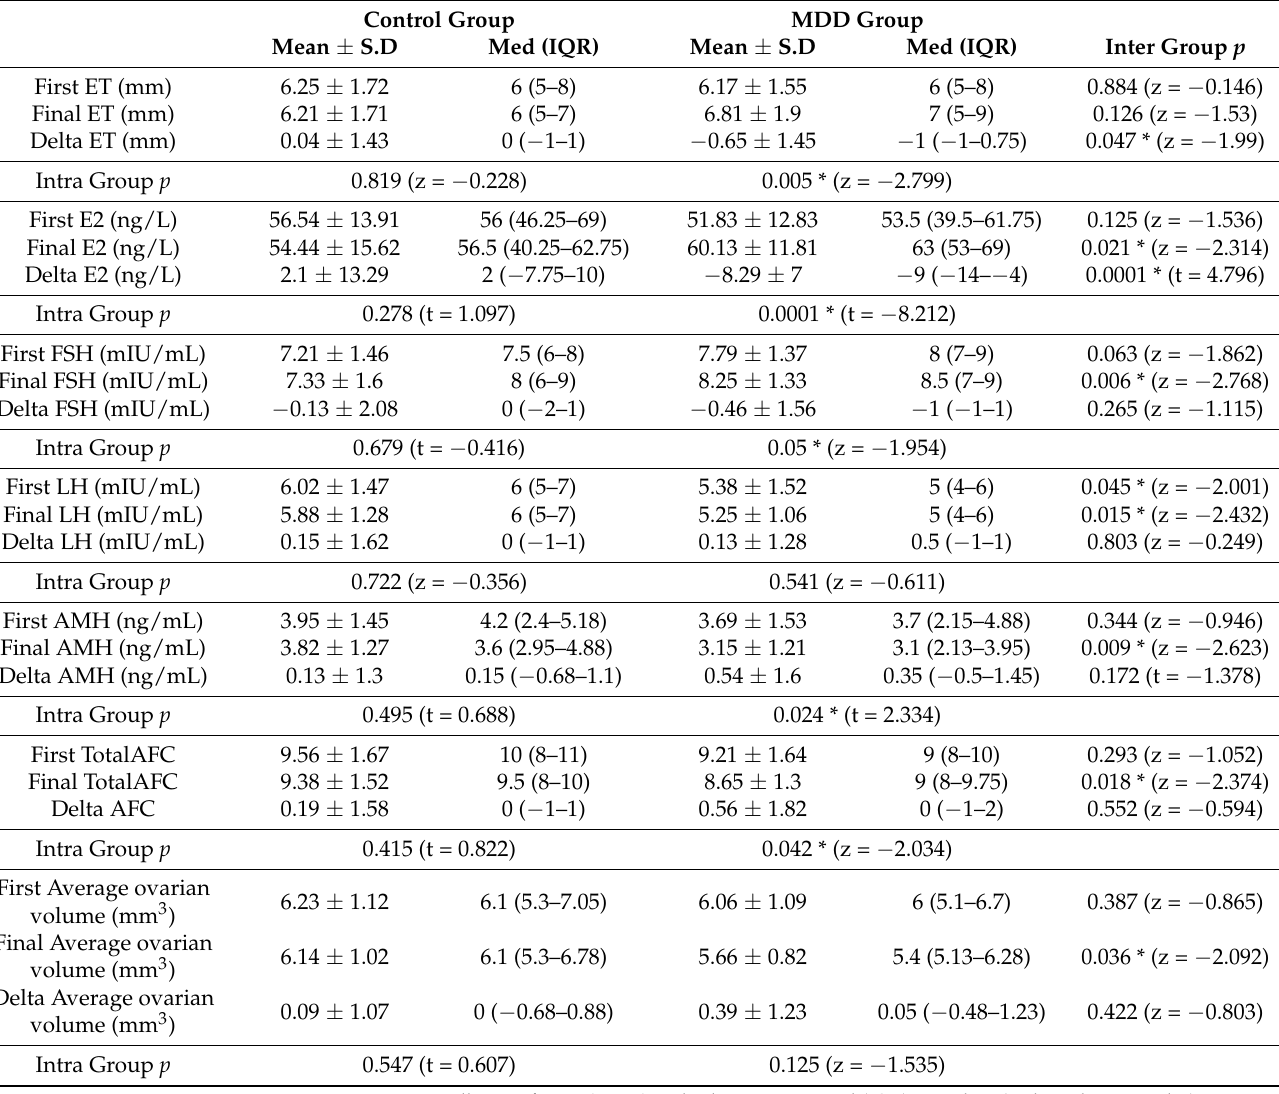
Table 2. Differences and changes in measurements according to the study